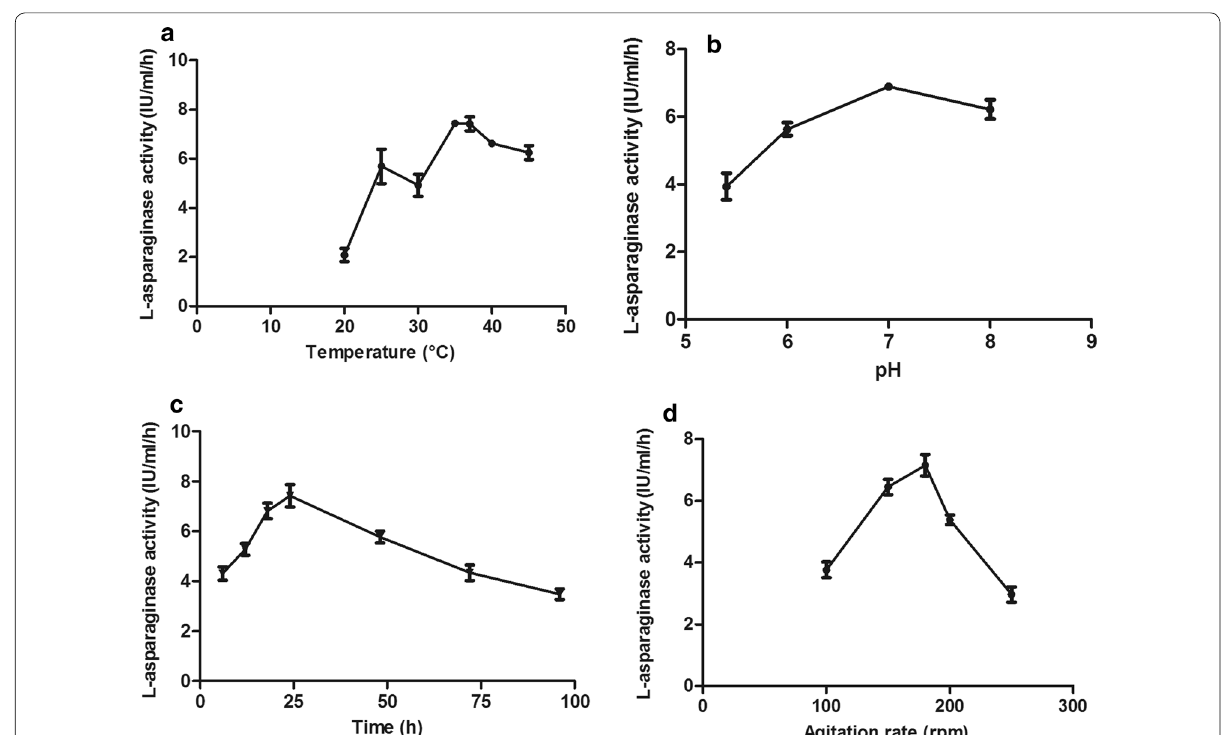
Fig. 4 Effect of incubation temperature ( a ), initial pH ( b ), incubation time ( c ), and agitation rate ( d ) on l -asparaginase production by Bacillus licheniformis mutant. The enzyme productivity was expressed in terms of catalytic